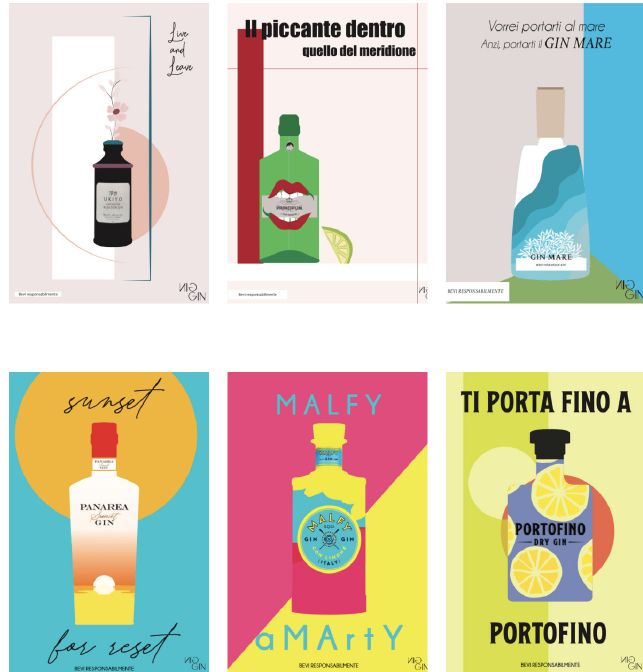
Fig.7 Advertising without rhetorical figures. (advertising for Gin alcohol: Grosso F., Piccirilli